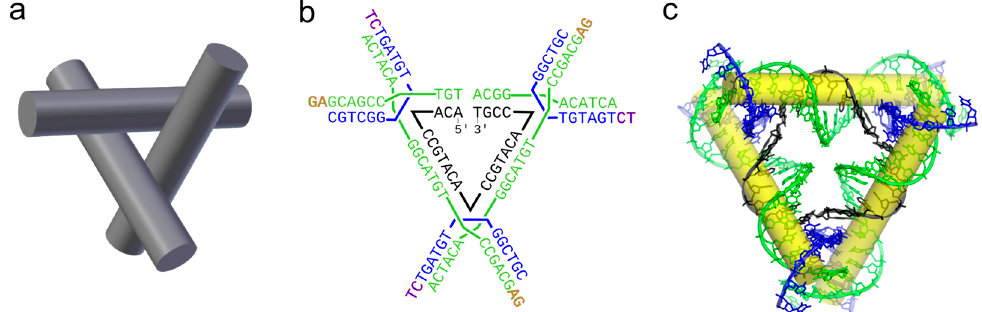
Figure 2. The tensegrity triangle motif. ( a ) Cylindrical representation of a tensegrity triangle, highlighting the three independent linear directions of the cylinders; ( b ) One example of three-fold symmetrized DNA tensegrity triangle. The central strand is in black, the edge strands are in green, and the cross-over strands in blue. 2 nt sticky ends are outlined in red; ( c ) The single DNA tensegrity triangle motif described by the crystal structure (PDBID: 3GBI). Strands are colored as in (b) and yellow cylinders connect the helix ends to show the three independent linear directions that multiple motifs extend into a 3D lattice.